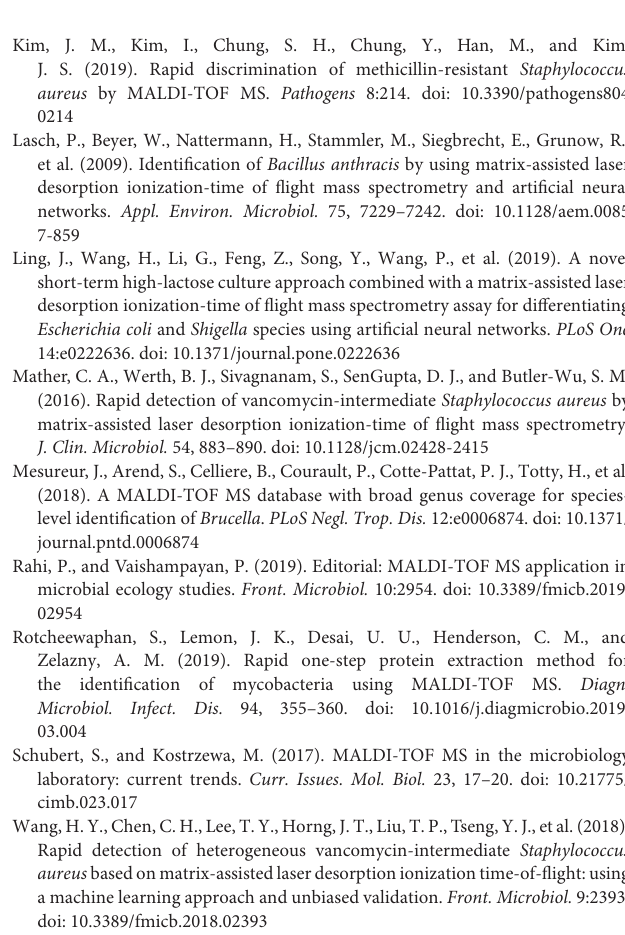
Supplementary Figure 1 | Schematic view of the BPNN model